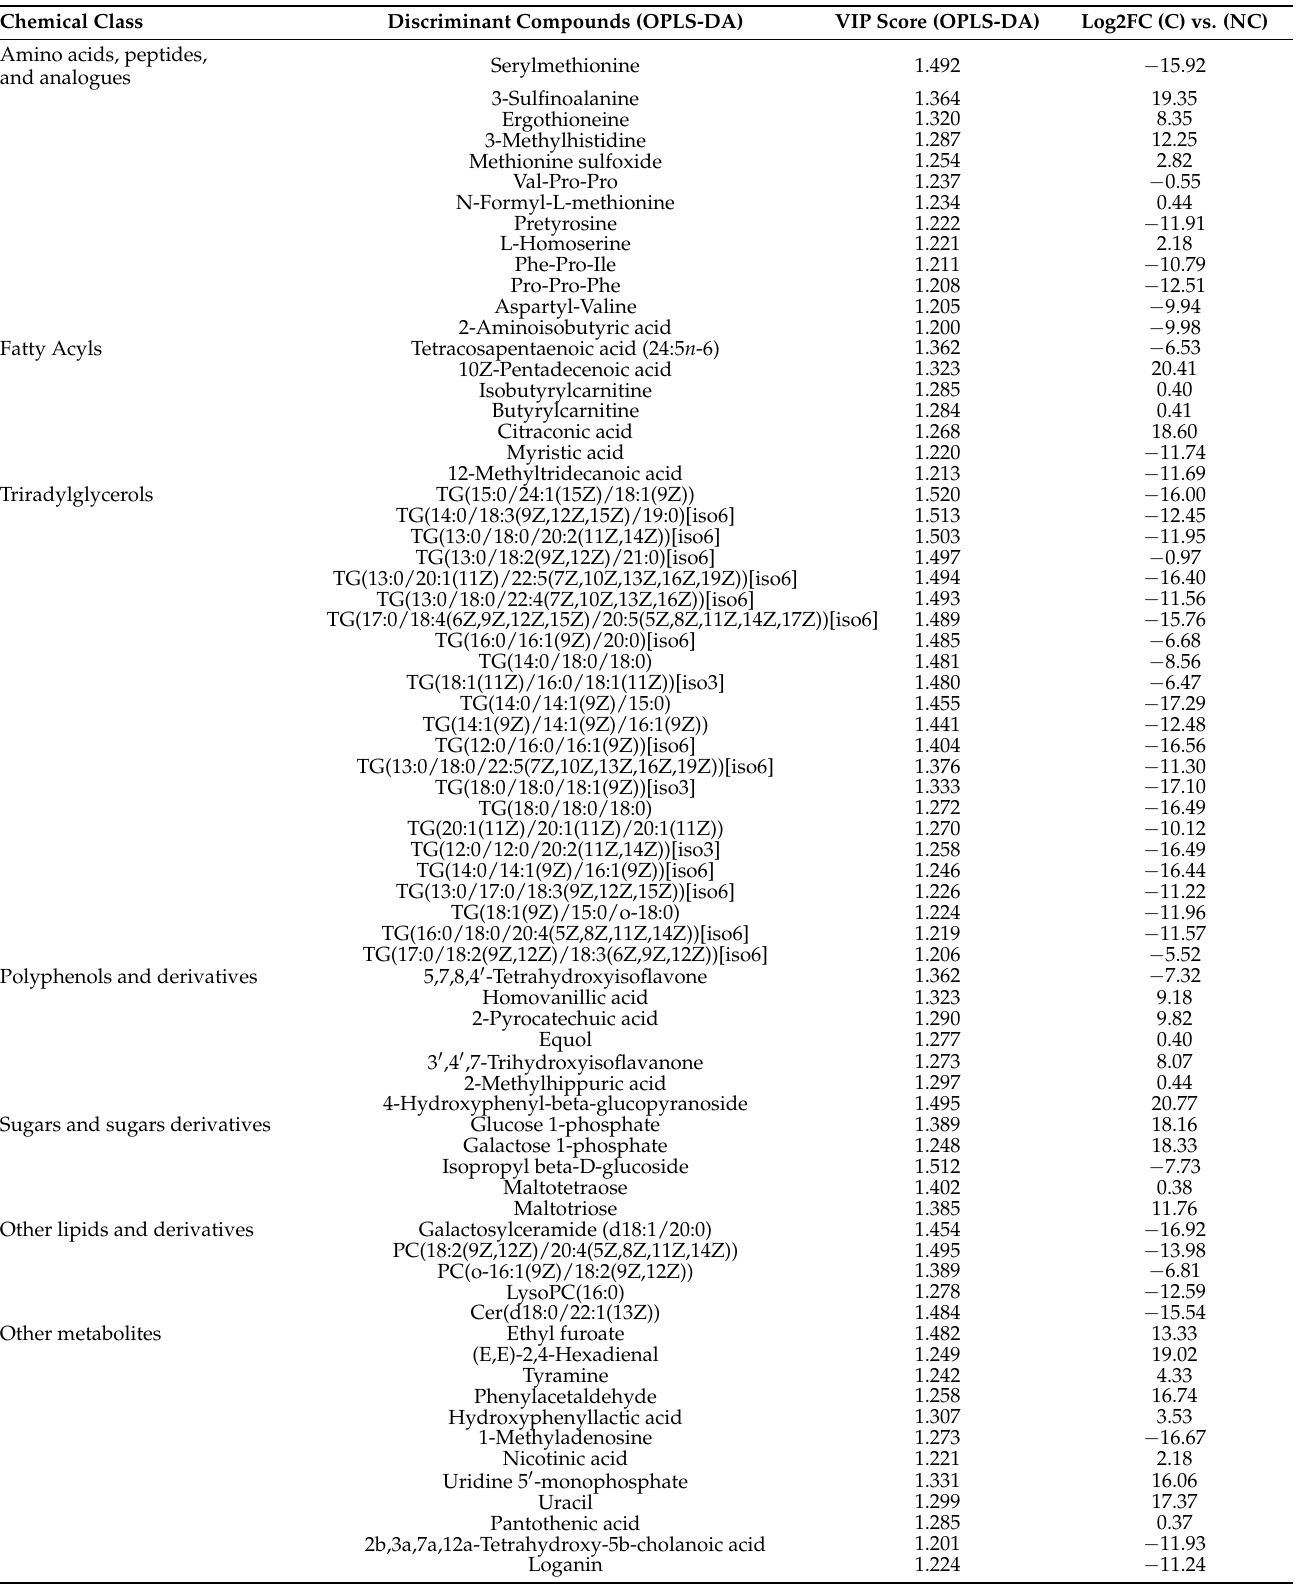
Table 3. VIP discriminant compounds resulting from the OPLS-DA based on the discrimination between creams obtained by natural creaming (NC) vs. centrifugation (C) methods. The VIP score and the Log2FC value are also provided. Chemical Class Amino acids, peptides, and